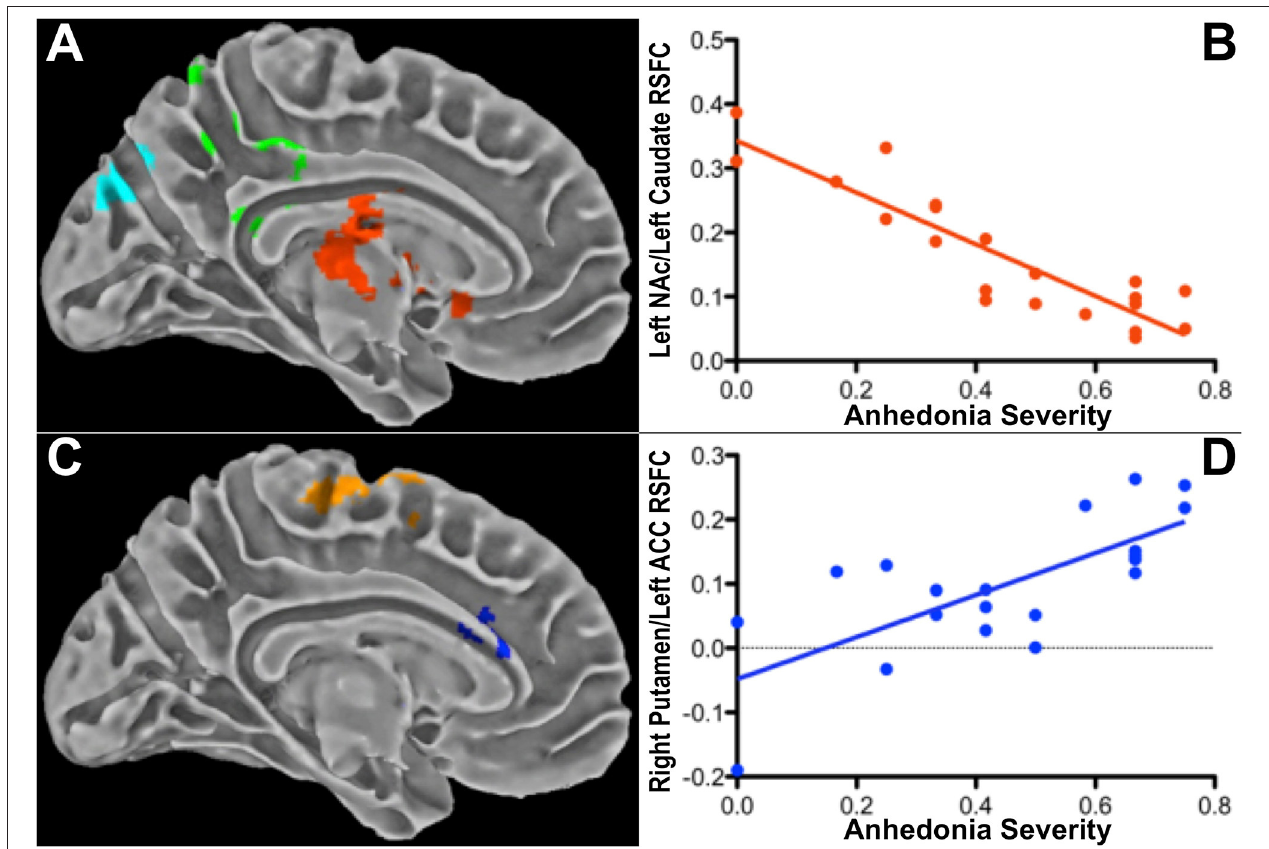
FIGURE 6 | Associations between striatal RSFC and anhedonia severity in 21 depressed adolescents (cluster-level p Bonferroni < 0.05) after controlling for overall depression severity. Anhedonia correlated (A,B) negatively with RSFC between the left nucleus accumbens (NAc) and a cluster (red) containing the left caudate and subgenual ACC; and (C,D) positively with RSFC between the right putamen and a cluster (blue) within the dorsal left dorsal ACC. Excerpted from (136).